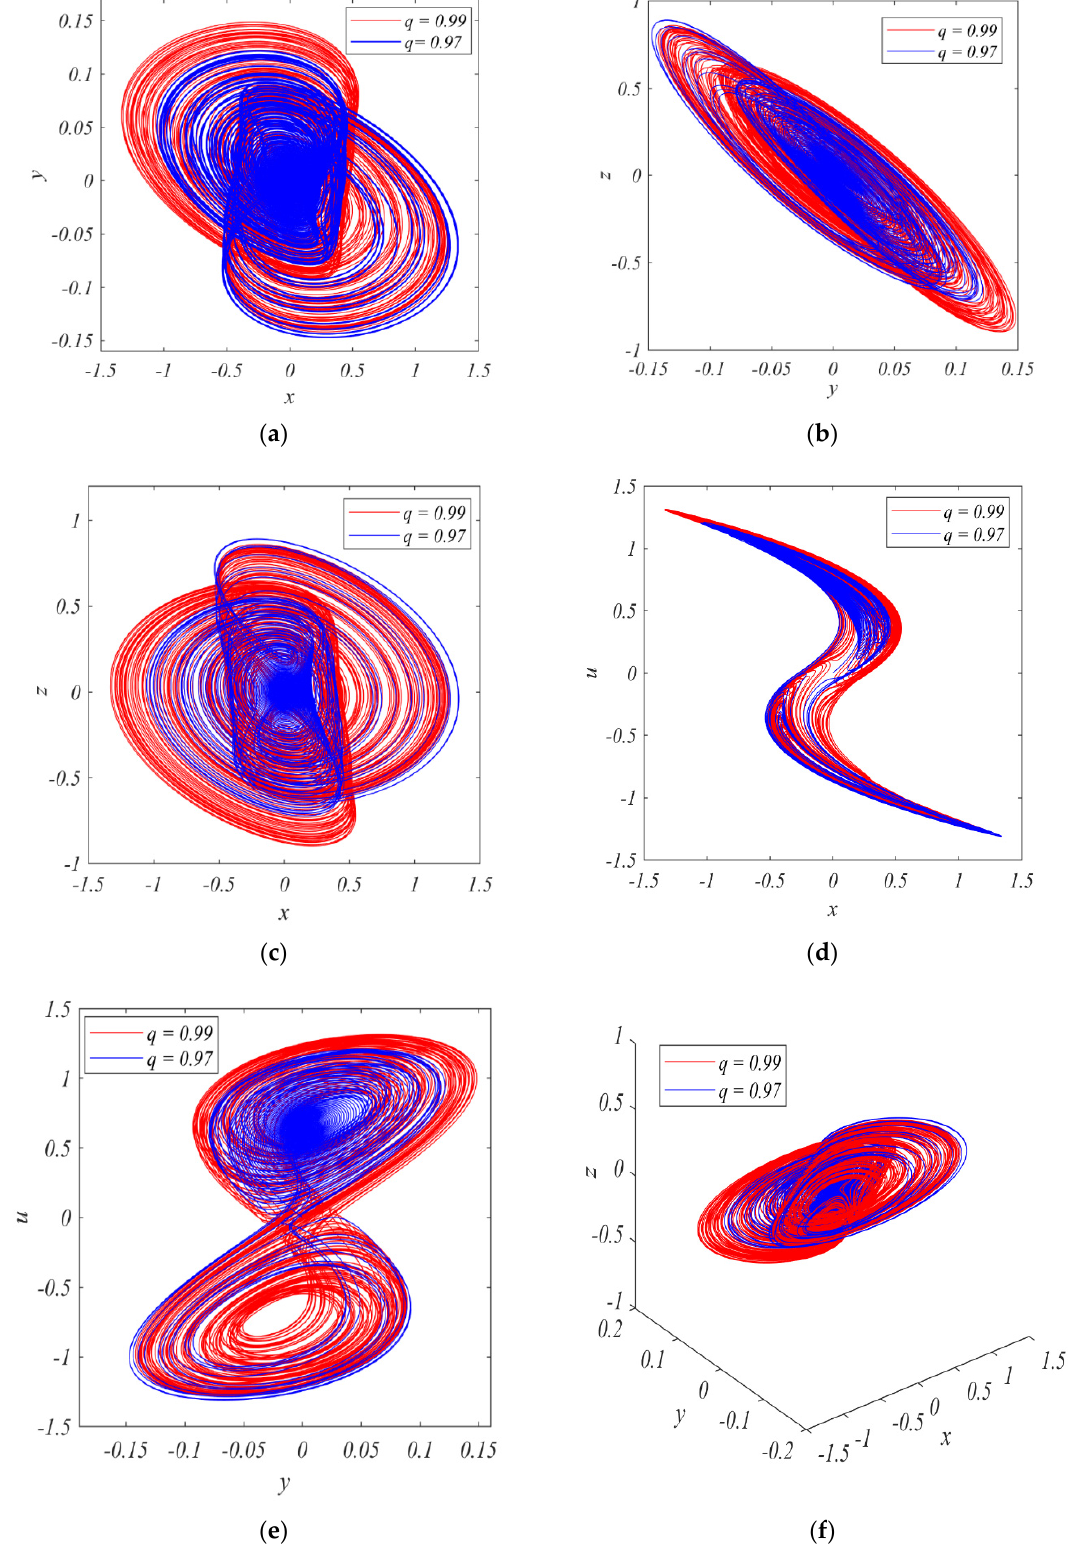
Figure 8. Chaotic attractors of the memcapacitive chaotic system: ( a ) x-y ; ( b ) y-z ; ( c ) x-z ; ( d ) x-u ; ( e ) y-u ; ( f ) 3-D layout ( x - y - z ).